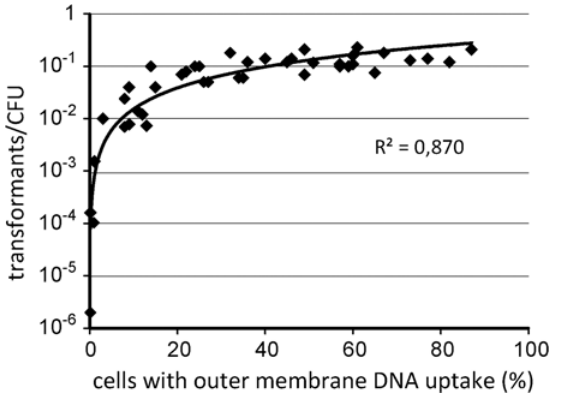
Fig 1. Transformation rate in H . pylori correlated with the fraction of cells with active outer membrane DNA transport. Cell suspensions were derived from the experiments illustrated in Fig 4. Bacteria with different competent fractions of cells were taken during or after competence development; non-competent cells were taken before competence development. H . pylori N6 were incubated in parallel with either Cy3-labelled λ DNA or a PCR fragment of rpsL (A128G), conferring streptomycin resistance. The data show the principle suitability of measuring the fraction of cells with active outer membrane DNA transport for the evaluation of competence development. Cumulative data from 13 independent experiments (n =